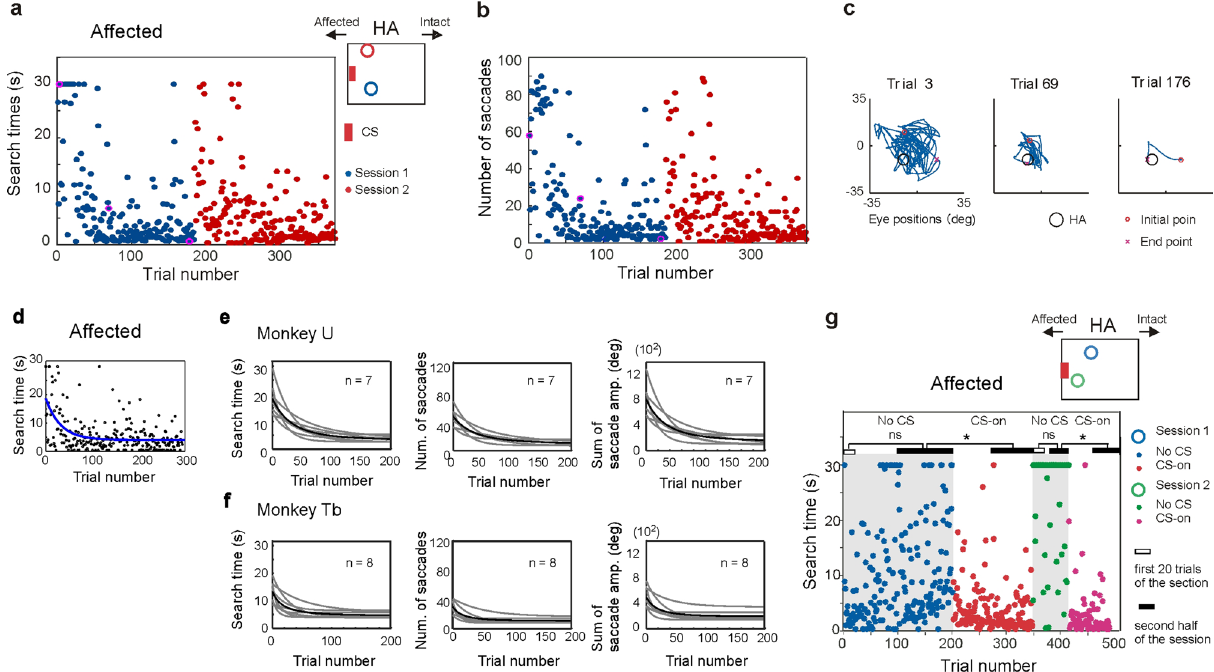
Figure 4. Instrumental learning with CS in the affected visual field. ( a ) and ( b ) Examples of reduction in search time ( a ) and number of saccades ( b ) when the CS was presented in the affected field. Search time and number of saccades for each trial was plotted against the trial number. HA position was altered in each session. ( c ) Eye position trajectories for three trials (trial 3, trial 69, trial 176) of session 1. The three trials are labeled by magenta circle in ( a ) and ( b ). ( d ) The optimally fitting decaying exponential curves (blue line) are superimposed on an example dataset for which the search time are plotted against the trial number in the session. ( e ) and ( f ) Population data that characterize the learning of HA location in the instrumental conditioning task. ( e ) Population data from monkey U. Decaying exponential fitting curves from sessions in the affected condition were superimposed. Means of the curves are indicated as thick black lines. ( f ) The population data from monkey Tb, the same arrangement as ( e ). ( g ) No CS condition. Learning failed to occur in the No CS conditions (grey hatched area) but was reinstated when the CS was presented to the affected field. *Wilcoxon rank sum test, p <